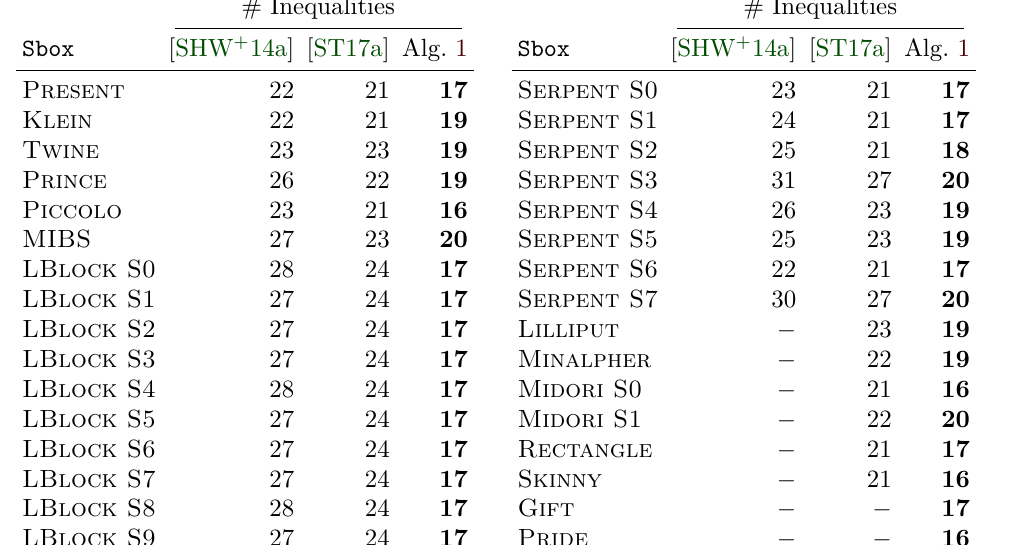
Table 2: Number of inequalities to model differential transitions for various 4-bit Sboxes # Inequalities # Inequalities Sbox [SHW + 14a] [ST17a] Alg.